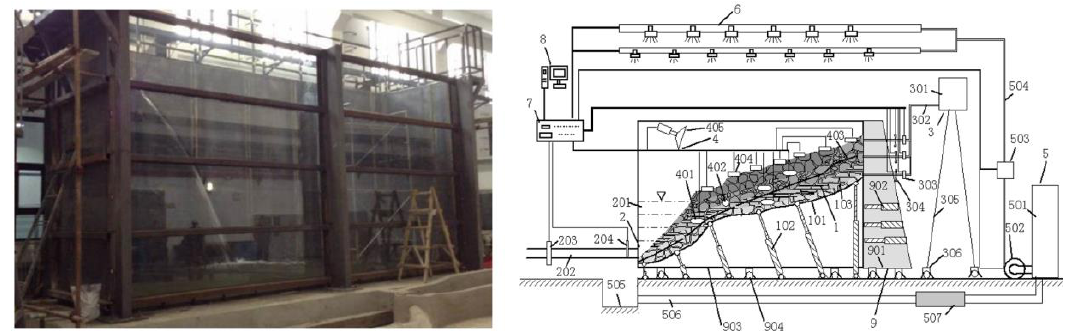
Figure 9. Large-scale physical experiment on deformation features of the reservoir bank under intensive atomization.